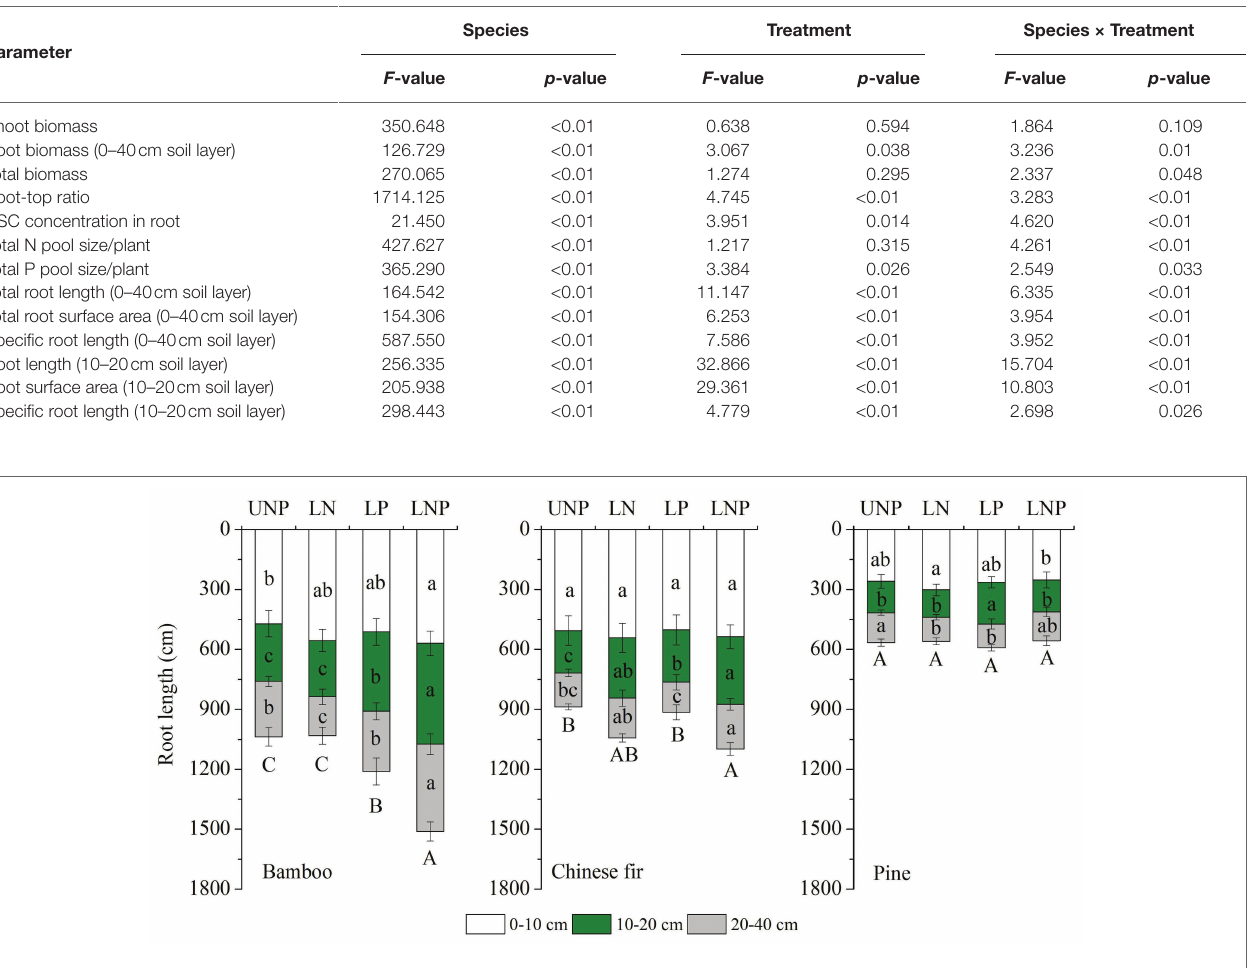
FIGURE 2 | Effects of different nutrient supply treatments on the root lengths of the three tree species in each soil layer. Different lowercase letters denote significant differences within the same soil layer for each species among treatments ( p < 0.05). Different capital letters denote significant differences in the total root length for each species among treatments ( p <